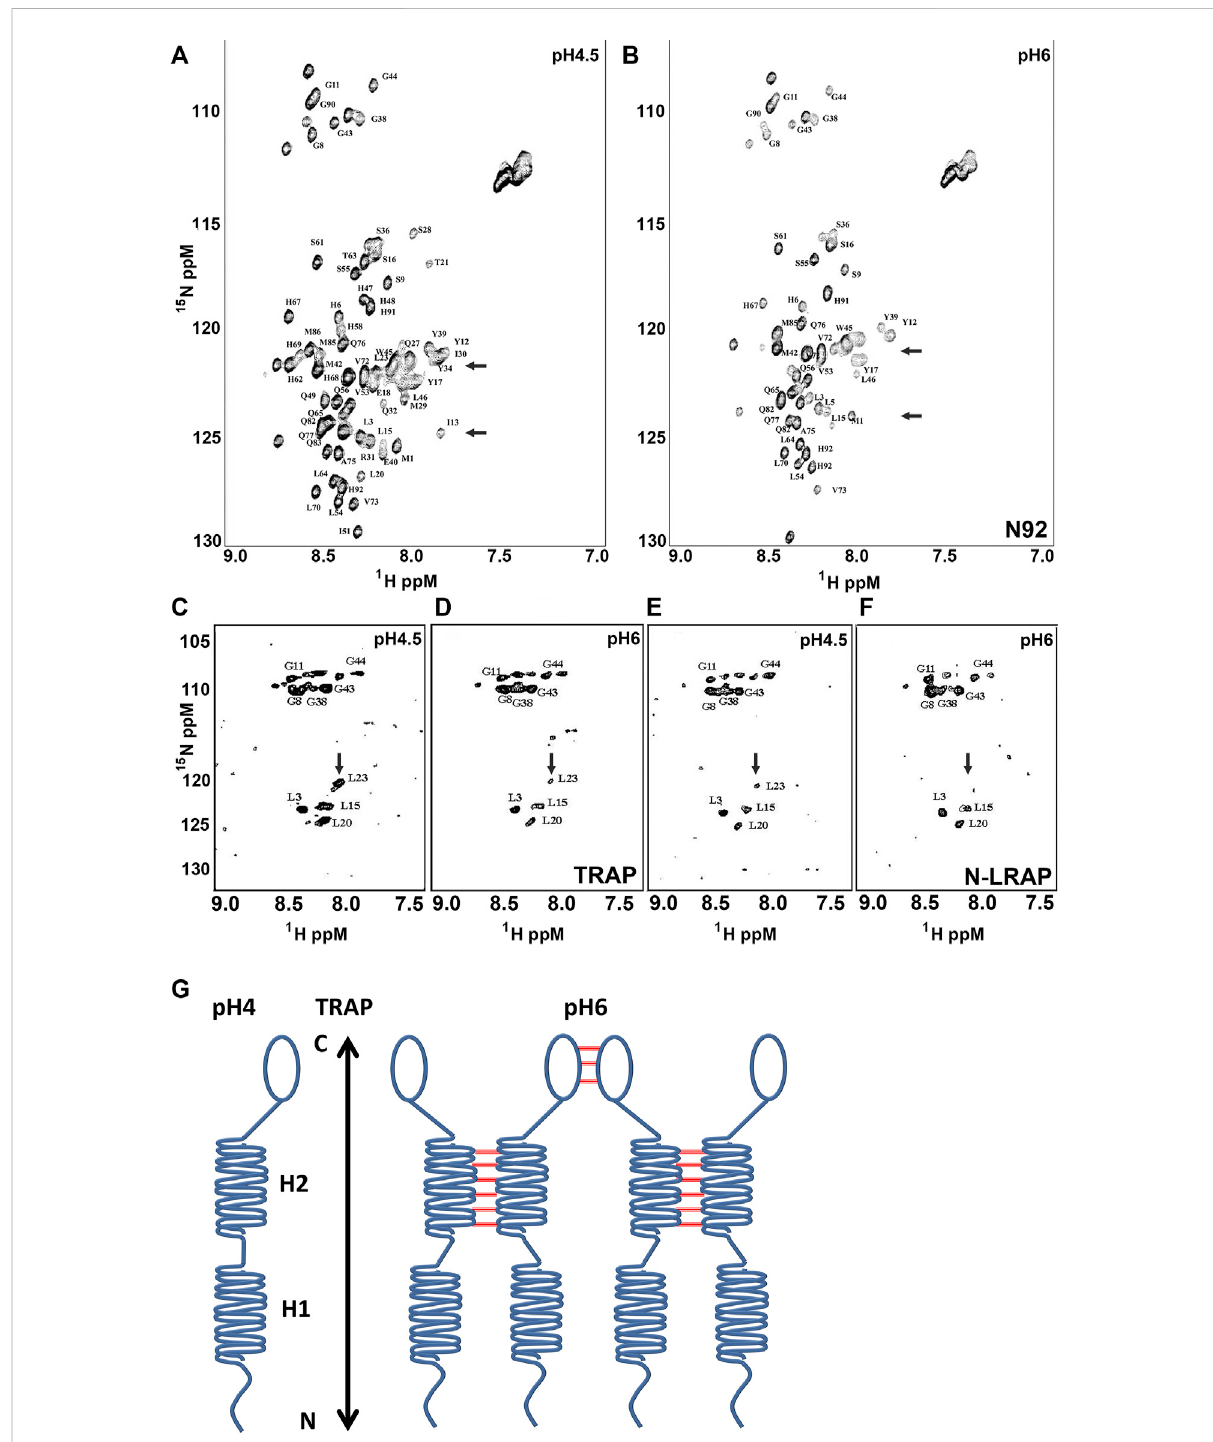
FIGURE 3 N-terminal amelogenin interactions at pH 4.5 and pH6. Figures A and B are HSQC spectra of N15 enriched Amelogenin (N92) at pH 4.5 (A) and pH6.0 (B) respectively. (C,D) are HSQC spectra of chemically synthesized amelogenin TRAP peptide (N1-45) with 15 N-enriched Gly (G8, G11, G38, G43andG44)andLeu(L3,L15,L20andL23)atpH4.5 (C) andpH6.0 (D) respectively. (E,F) areHSQCspectraoftheselectedlabeledTRAPpeptidein the presence of a short peptide containing the fi rst terminal 33 amino acid residues (N33, the N-terminal portion of LRAP) at pH 4.5 (E) and pH6.0 (F) . (G) is a model representing proposed intermolecular interactions between amelogenin molecules, with tight intermolecular bonds between the H2 helices in the non-LRAP TRAP region (AA34-45) and weak interactions at the amelogenin C-terminus. The H1 helices in the LRAP region did not feature any notable